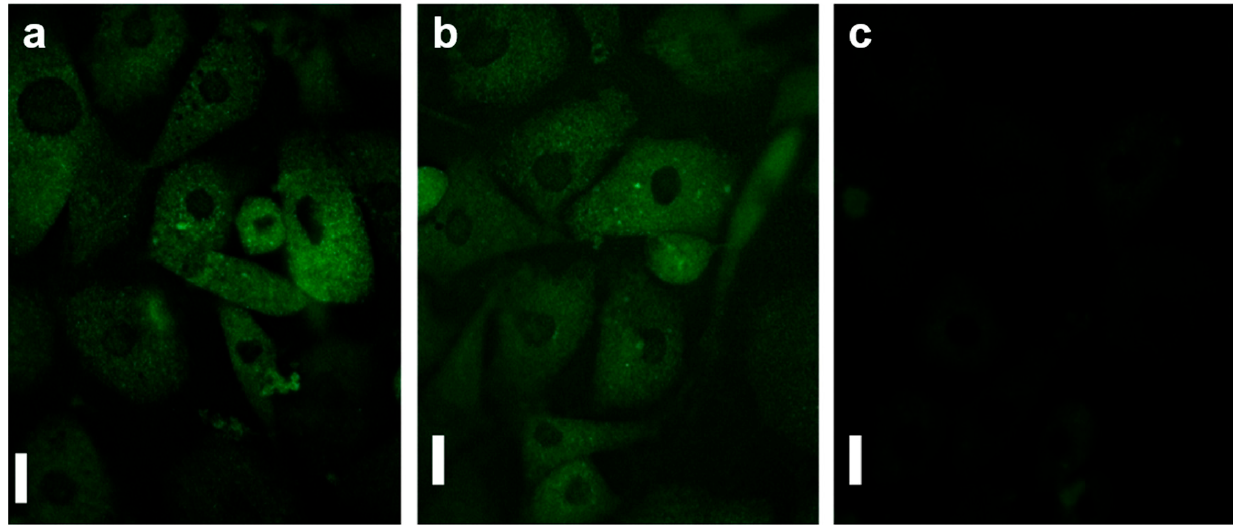
Figure 9. Fluorescence micrographs depicting the staining of OCN cells cultured on substrates patterned with 4 µ m sized tMPs ( a ), on substrates patterned with 2 µ m sized tMPs ( b ) and on flat surfaces ( c ), respectively. Scale bars represent 15 µ m. Adapted with permission from ref. [161]. Fibronectin was further employed by Shukla et al., who fabricated micropatterned fibronectin arrays of biomimetic geometries that replicated the morphology aspect of mature cells. Adipocytes cultured in 2D were imaged and used to create biomimetic virtual masks which were then employed to pattern the fibronectin surfaces via the laser scanning lithography. Reported results pointed out a clear influence of the pattern geometry on human MSC differentiation (Figure 10). While human MSCs seeded on nonpatterned fibronectin surfaces in differentiation medium showed positive staining for both lipids and ALP (~10% of the cells stained positive for lipids, ~20% of the cells stained positive for ALP and the remaining cells were not positive for either marker), the MSCs cultured on mimetic patterns in the same differentiation medium showed positive staining for lipids (45% of the cells) and ALP staining was not present in any of the MSCs [165]. In conclusion, the mimetic geometry determined the human MSCs to differentiate into